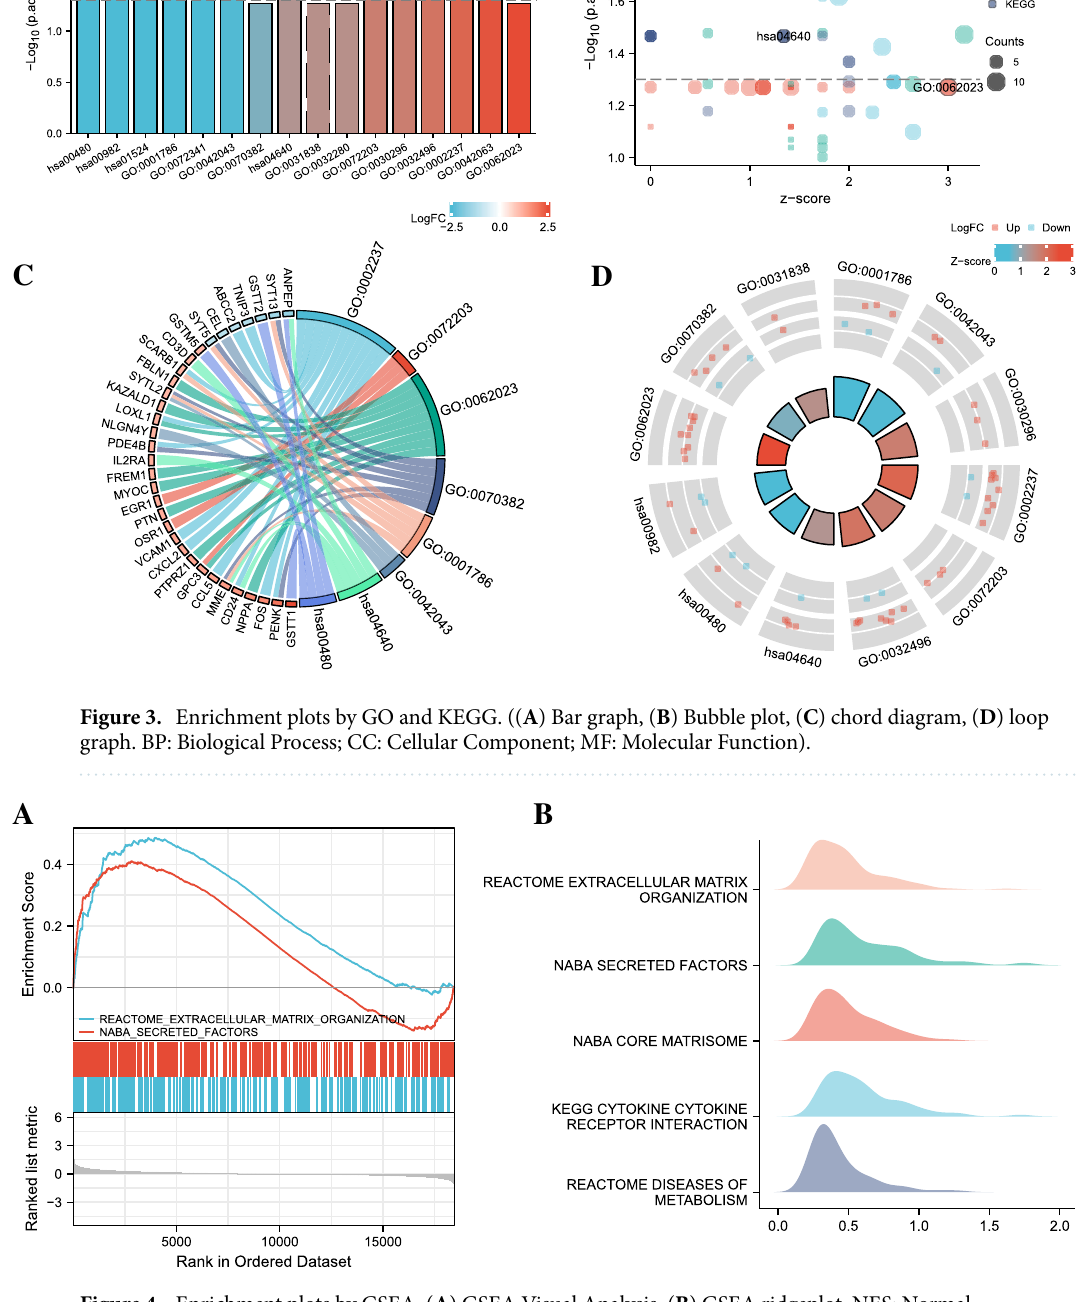
Figure 4. Enrichment plots by GSEA. ( A ) GSEA Visual Analysis, ( B ) GSEA ridgeplot. NES: Normal Enrichment Score; FDR: False Discovery